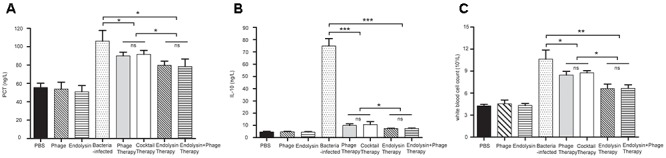
Levels of WBC and cytokines in the blood of the different groups of mice. The blood of the mice in the groups of PBS, phage, endolysin, bacteria-infected, Phage therapy, Phage cocktail therapy, Endolysin therapy and Endolysin + phage therapy were collected at 2 days. (A) PCT and (B) IL-10 concentrations of serum were measured by ELISA. (C) Blood was sent to the clinical laboratory to examine WBC. The data were shown in the mean ± SD (n = 3). ∗P < 0.05, ∗∗P < 0.01, and ∗∗∗P < 0.001. WBC, white blood cell count. IL-10, interleukin-10. PCT, procalcitonin.